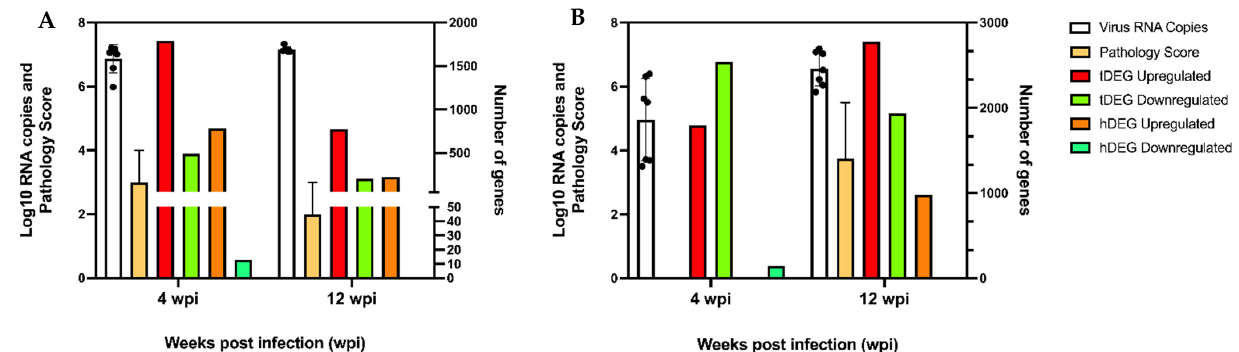
(Table 2). Only 11 of the hDEGs were shared between 4 and 12 wpi (Figure 3B), including both up- and downregulated genes.